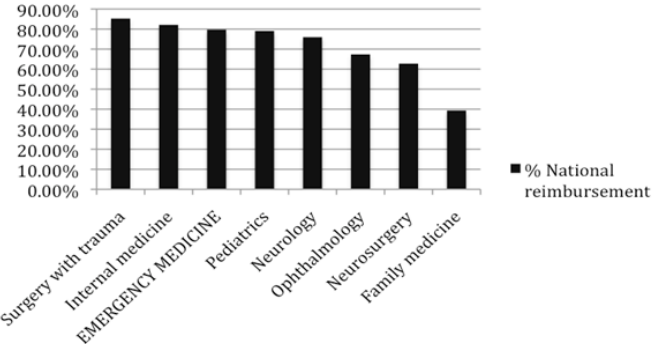
Figure 6 . Reimbursement per relative value unit (RVU) for all study site patients by specialty, as a percentage of national reimbursement per RVU from Medical Group Management Association ( MGMA) data for 8 specialties. All patient data not available at study site for 4 specialties: obstetrics and gynecology, head and neck surgery, orthopedics and plastic